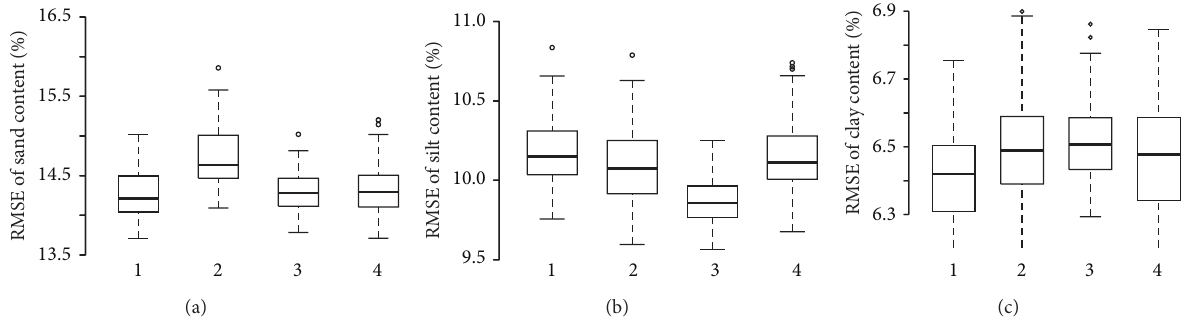
Figure 4: Prediction error distributions as RMSE of the four random forest modelling procedures.